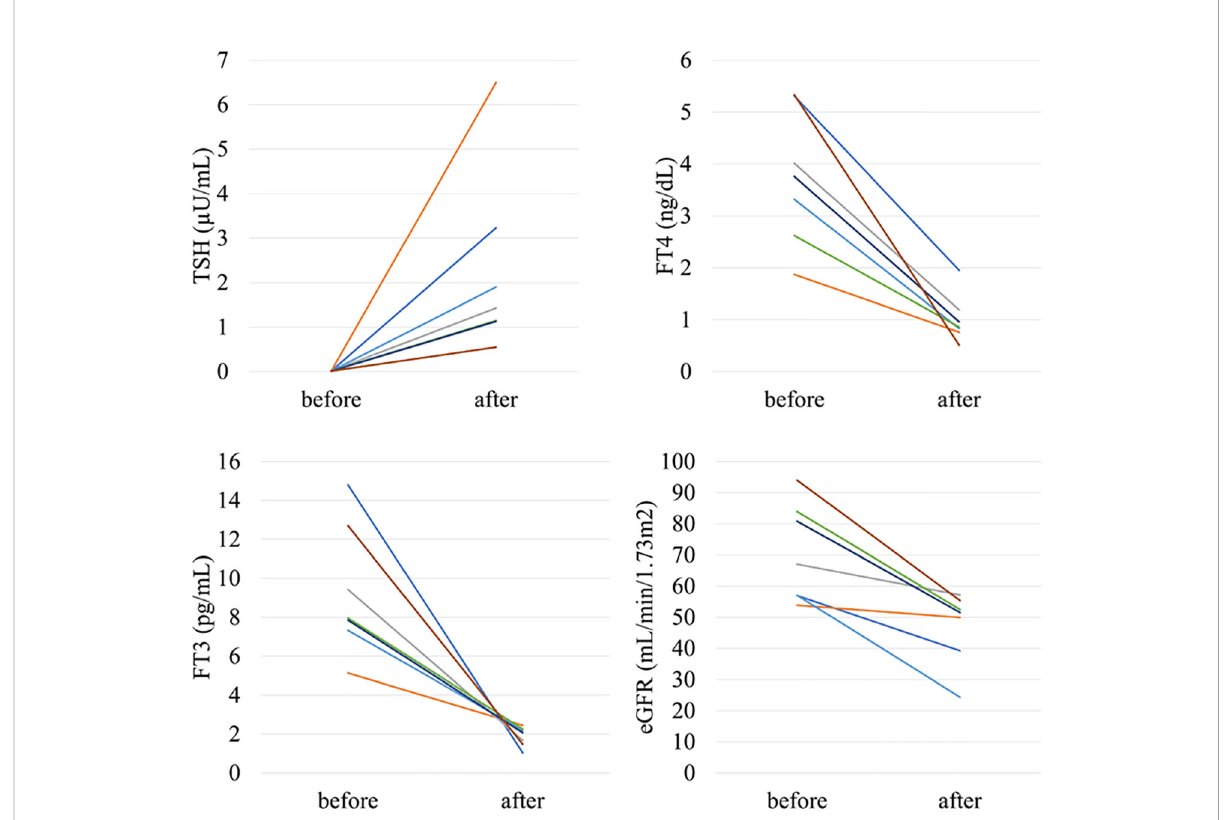
FIGURE 2 Changes in kidney and thyroid function before and after treatment in “ masked ” CKD and CKD patients in